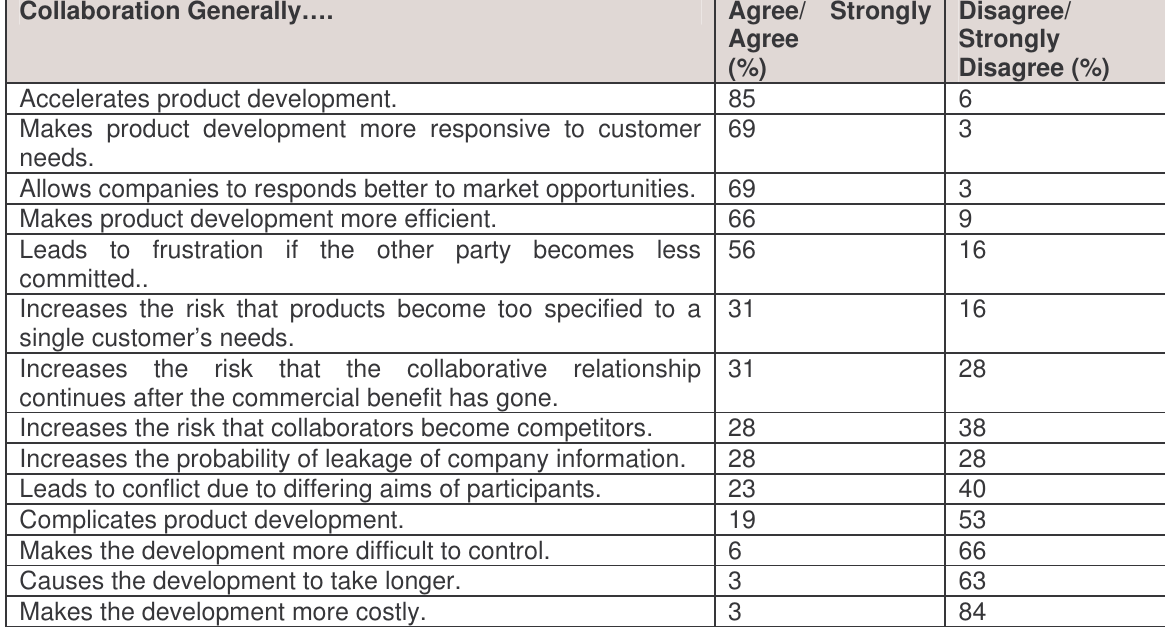
Table 2: The effect of collaboration on the new product development process Collaboration